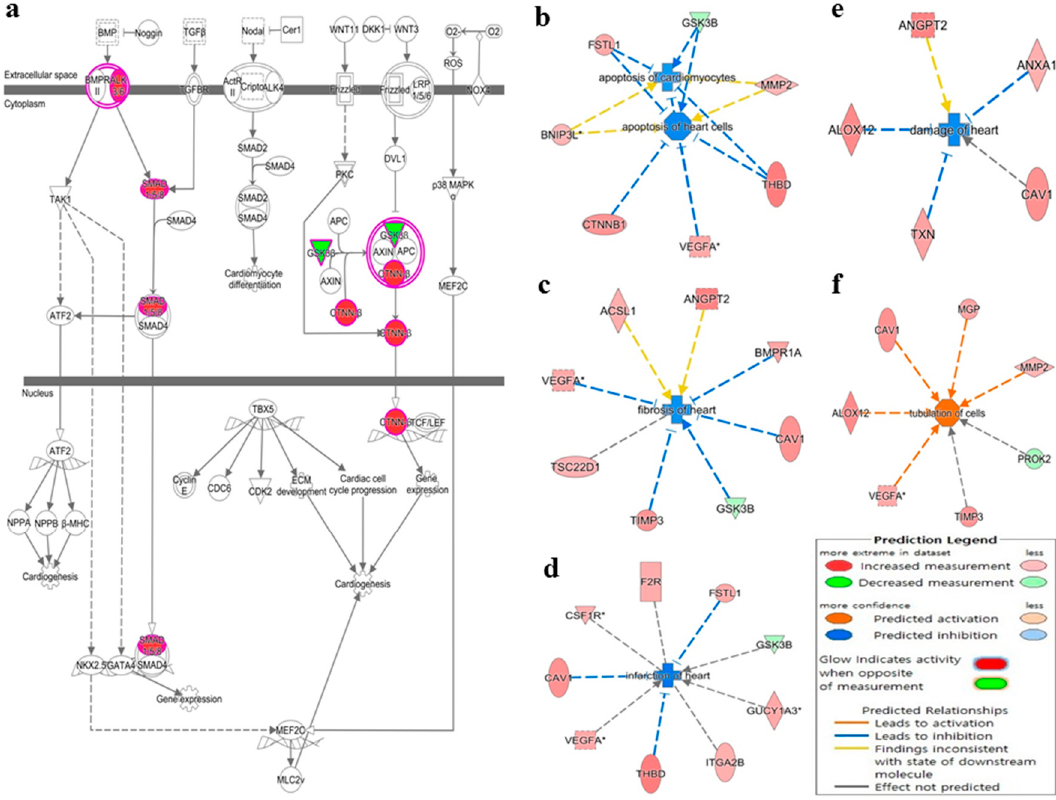
Figure 3. Potential alteration in cardiogenesis in Rag2 KO mice. ( a ) The upregulated expression of factors indicating the promotion of cardiogenesis in Rag2 KO mice; ( b ) Apoptosis of the cardiomyocytes and heart cells are potentially inhibited in Rag2 KO mice; ( c ) Cardiac fibrosis is potentially inhibited in Rag2 KO mice; ( d) Cardiac infection is potentially inhibited in Rag2 KO mice; ( e ) The possibility of heart damages is potentially inhibited in Rag2 KO mice; ( f ) Cardiac tubulation is potentially upregulated in Rag2 KO mice.